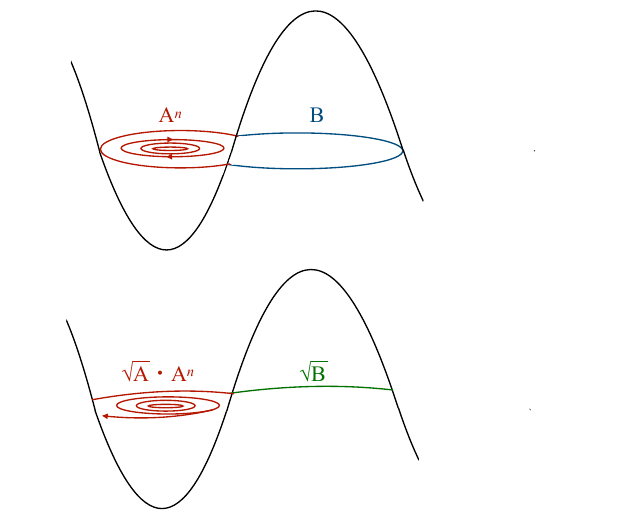
√ Figure 4 . To be periodic, BA n and BA n + 1 2 is the unit of nonperturbative contribution. The Stokes phenomenon corresponding to the bion ambiguity is regarded as A → A − 1